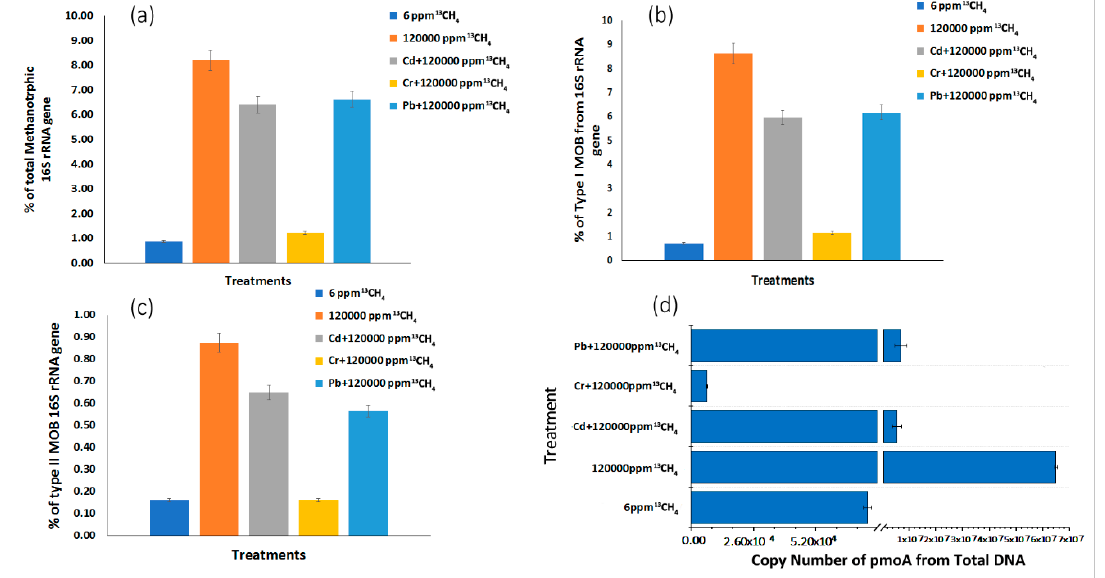
Figure 3. Illumina sequencing was carried out at the whole epipelon microbial community level in microcosms targeting total methanotrophs from total 16S rRNA genes ( a ), and the relative abundances of type I ( b ), type II ( c ), The pmoA gene copy numbers were assessed using real-time quantitative PCR ( d ).